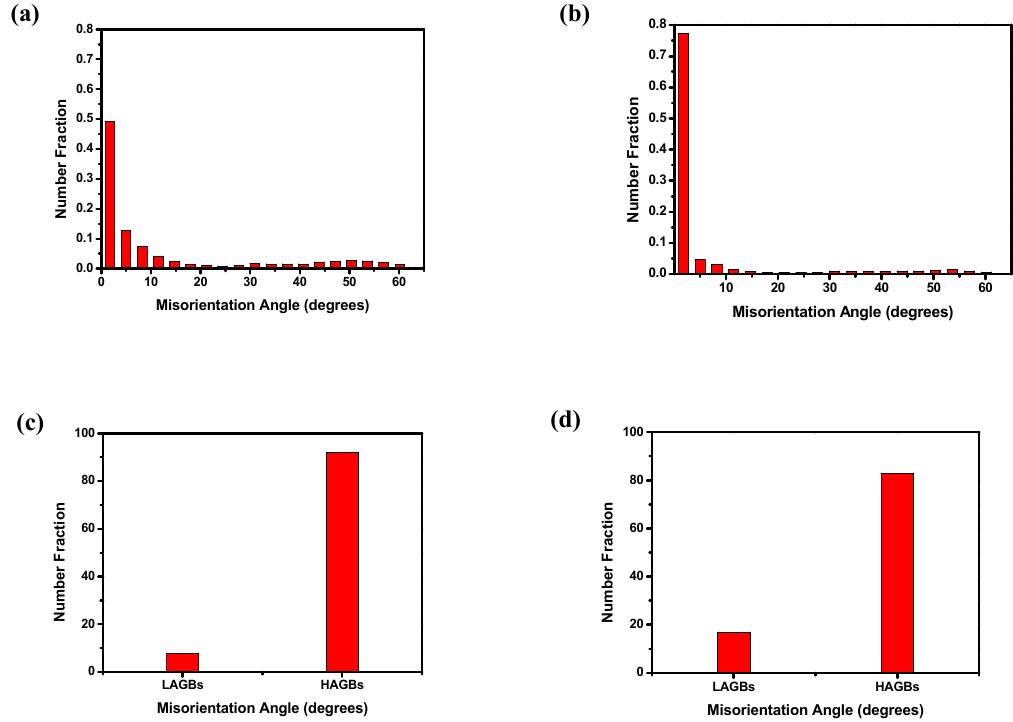
Figure 4. Number of fractions with respect to the misorientation angle for the bulk ( a , b ) and 3D-printed ( c , d ) AISI H13 tool steel specimens before and after UNSM treatment.